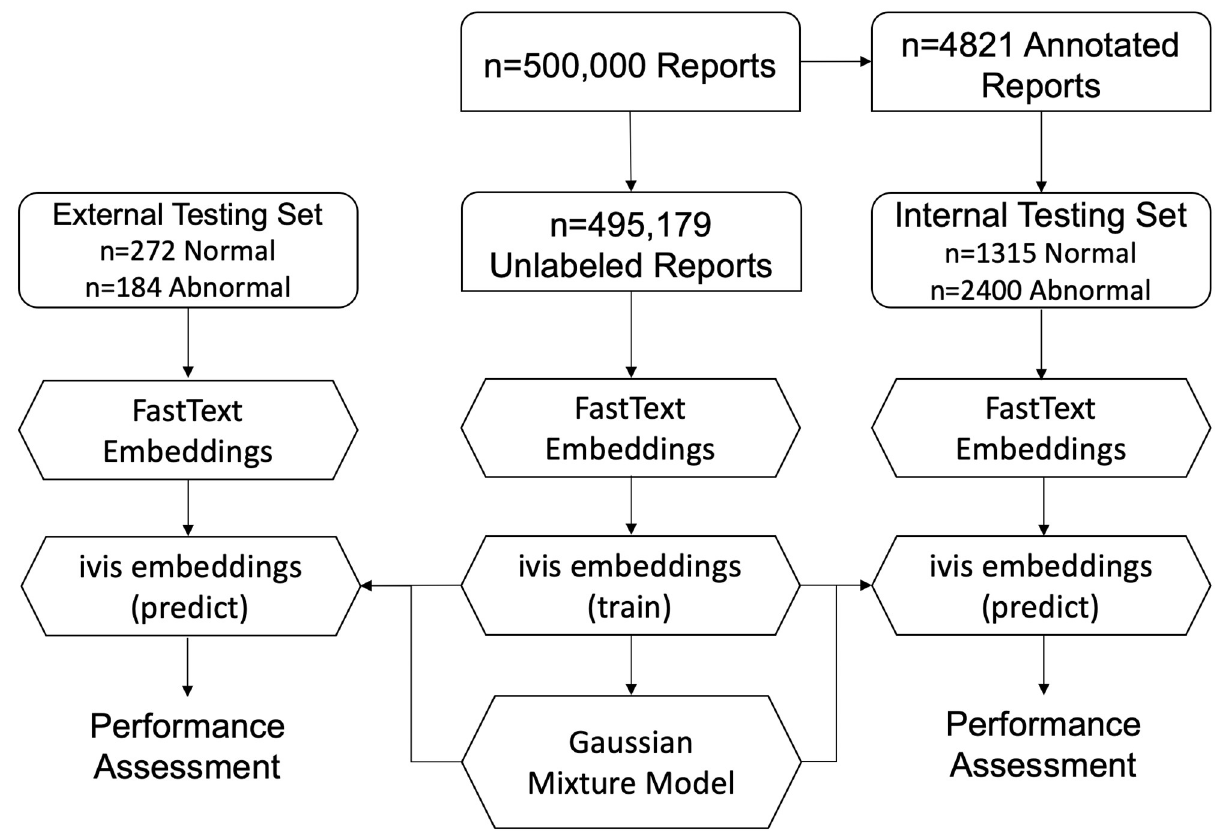
Fig 2. Flowchart demonstrating unsupervised approach to radiology report